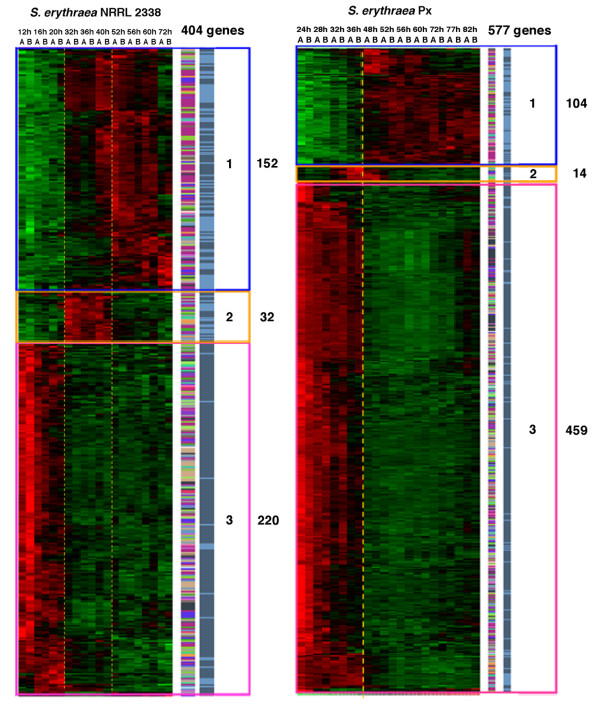
Microarray analysis showing changes in global control of cell-cycle. Visualization by dChip of 404 S. erythraea NRRL2338 and of 577 S. erythraea Px differentially expressed genes, selected by a q-value < = 0,001, and determining a time course gene expression profiling and a hierarchical clustering of the samples (Red = up-regulation; Green = down-regulation); on the right side of the figure, two columns respectively show the functional classification of the DEGs whose transcription profile is visualized and their positional distribution in the core (dark blue) and non core region (light blue) of the genome.